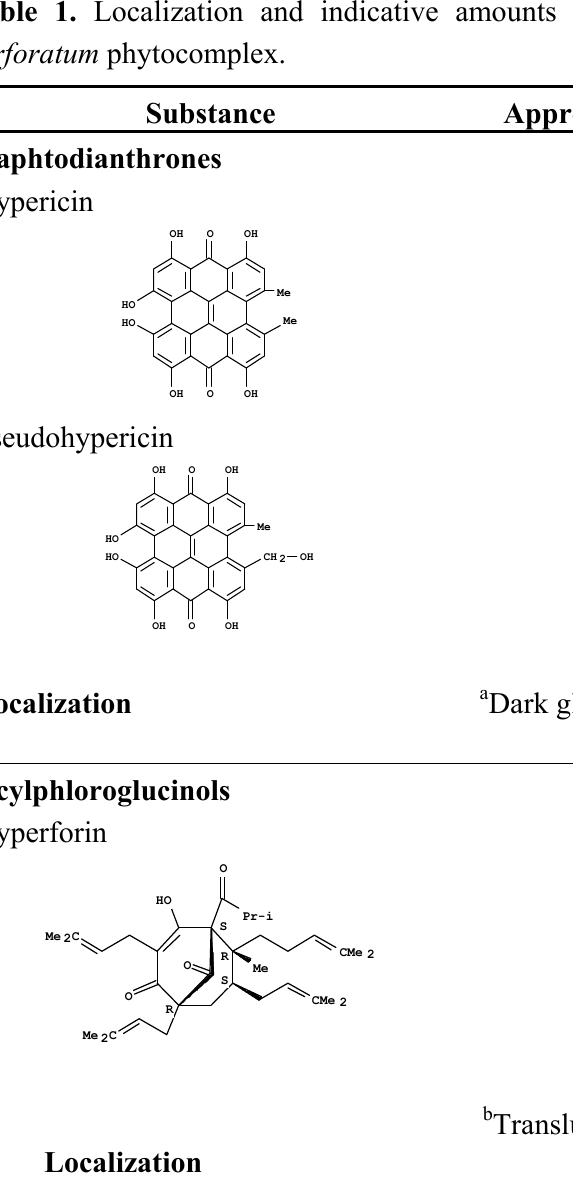
Table 1. Localization and indicative amounts of most significant constituents of